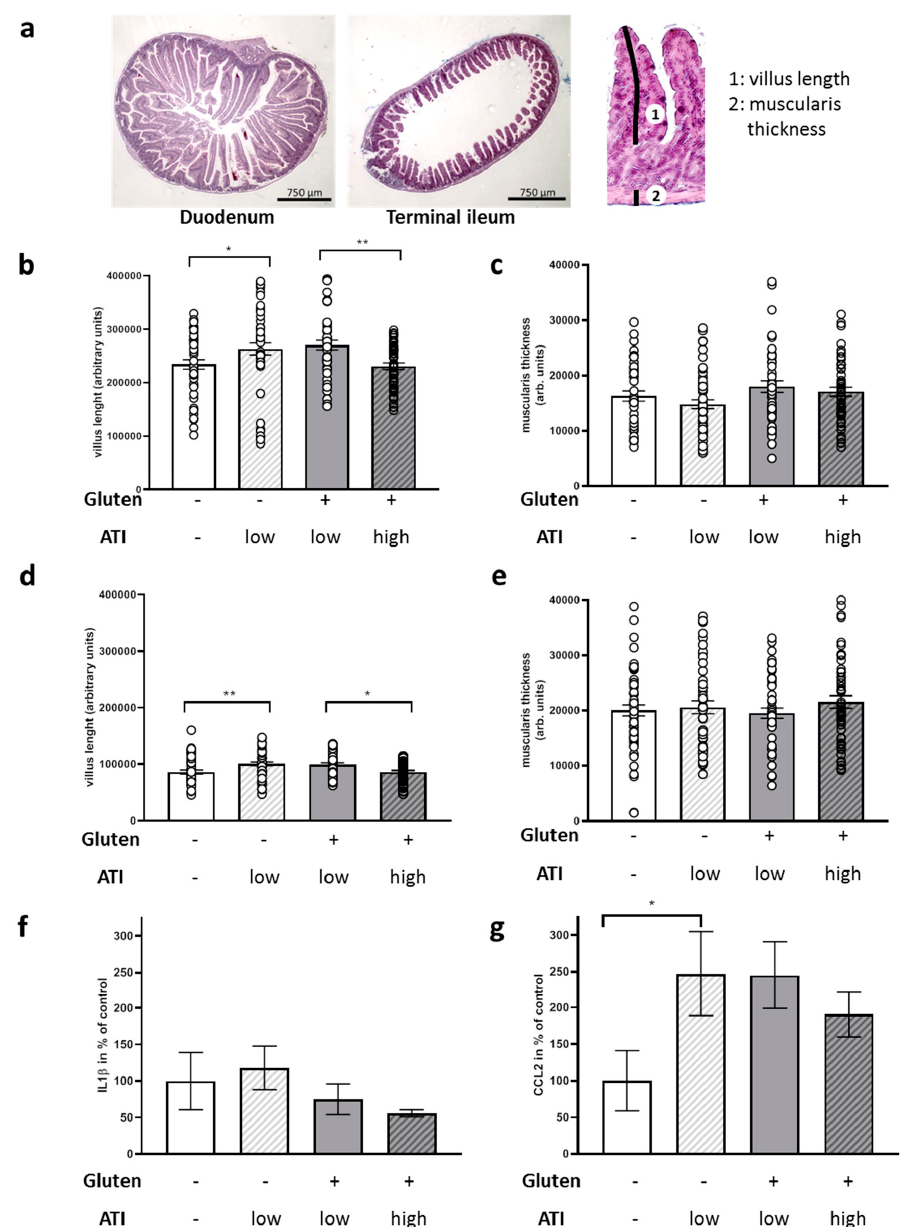
Figure 3. Micromorphological measurements and quantitation of inflammatory markers in the small intestine of 5xFAD mice fed with ATI-deficient or ATI-supplemented diet. Tissue specimens were drop-fixed and subsequently two slices per tissue sample and animal were used for HE staining. Length of two villi and the thickness of the underneath located muscularis were measured per slide. ( a ) Exemplary pictures of duodenum and terminal ileum. For an example of measures of villus length (1) or muscularis thickness (2), see the magnified segment of the terminal ileum on the right. ( b ) Relative measures of duodenal villi. ( c ) Thickness of muscularis from duodenum. ( d ) Villus length within terminal ileum sections. ( e ) Muscularis thickness within terminal ileum sections. All data are given as mean ± SEM. Statistical analysis was performed by One Way ANOVA (Sidak’s multiple comparisons test; *, p < 0.05; **, p < 0.01; n = 7 animals per group). ( f ) Interleukin 1 β (IL1 β ) and ( g ) C–C motif chemokine ligand 2 (CCL2) mRNA levels of terminal ileum were quantified by qPCR and normalized to beta actin mRNA levels. Data present mean ± SEM. Statistical analysis was performed by One Way ANOVA (Uncorrected Fisher’s LSD test; *, p < 0.05; n = 4–8 animals per